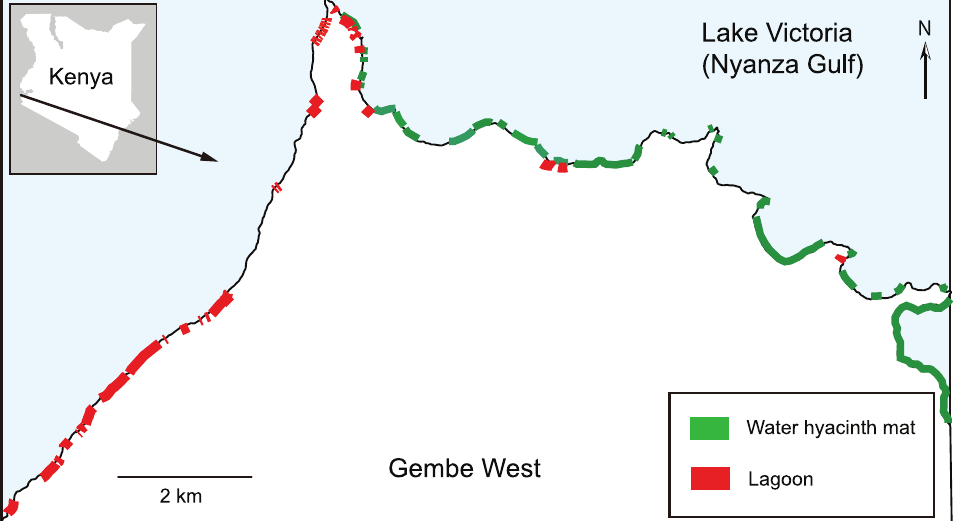
Figure 1. Distribution of water hyacinth mats and lagoons.